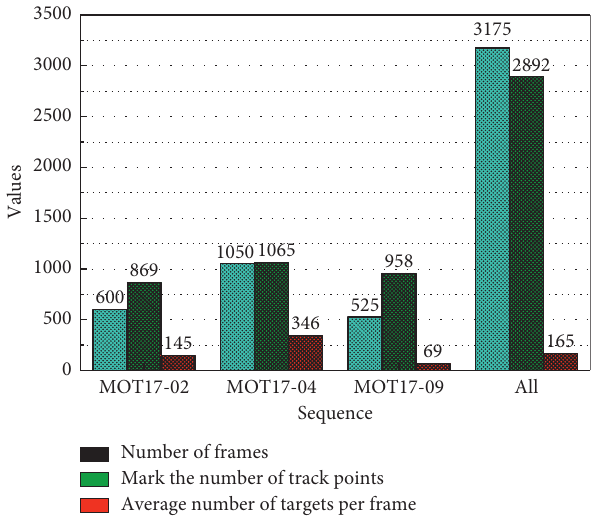
4: Multitarget tracking experimental test set parameters.